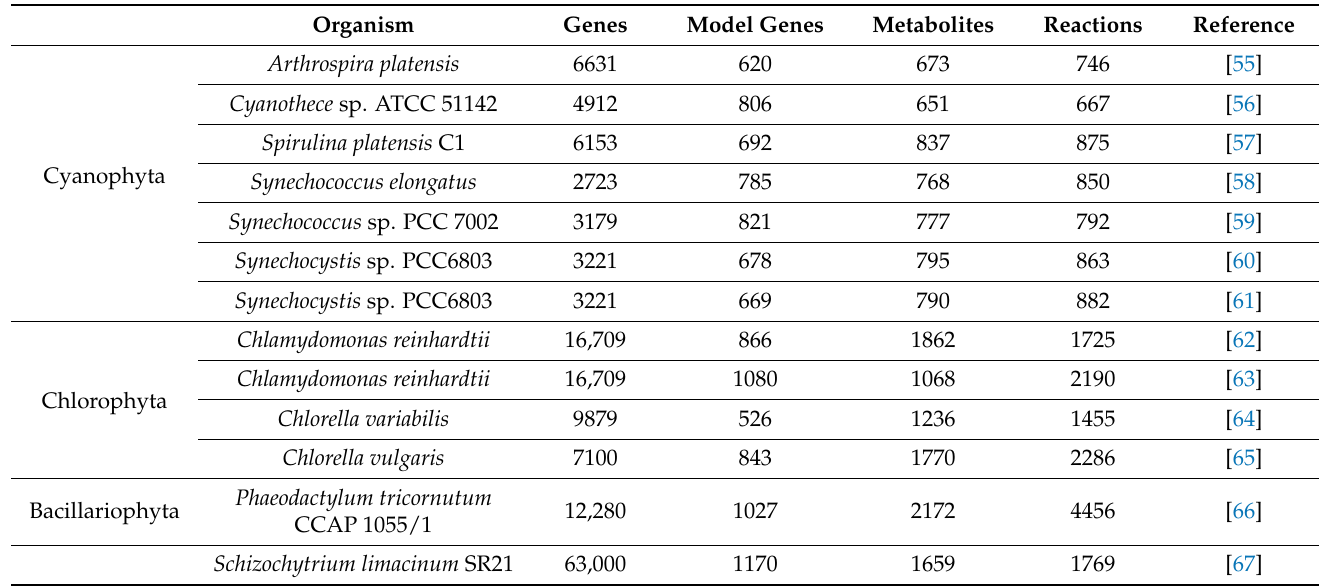
Table 1. Comparison of genome-scale metabolic networks between cyanobacteria and eukaryotic